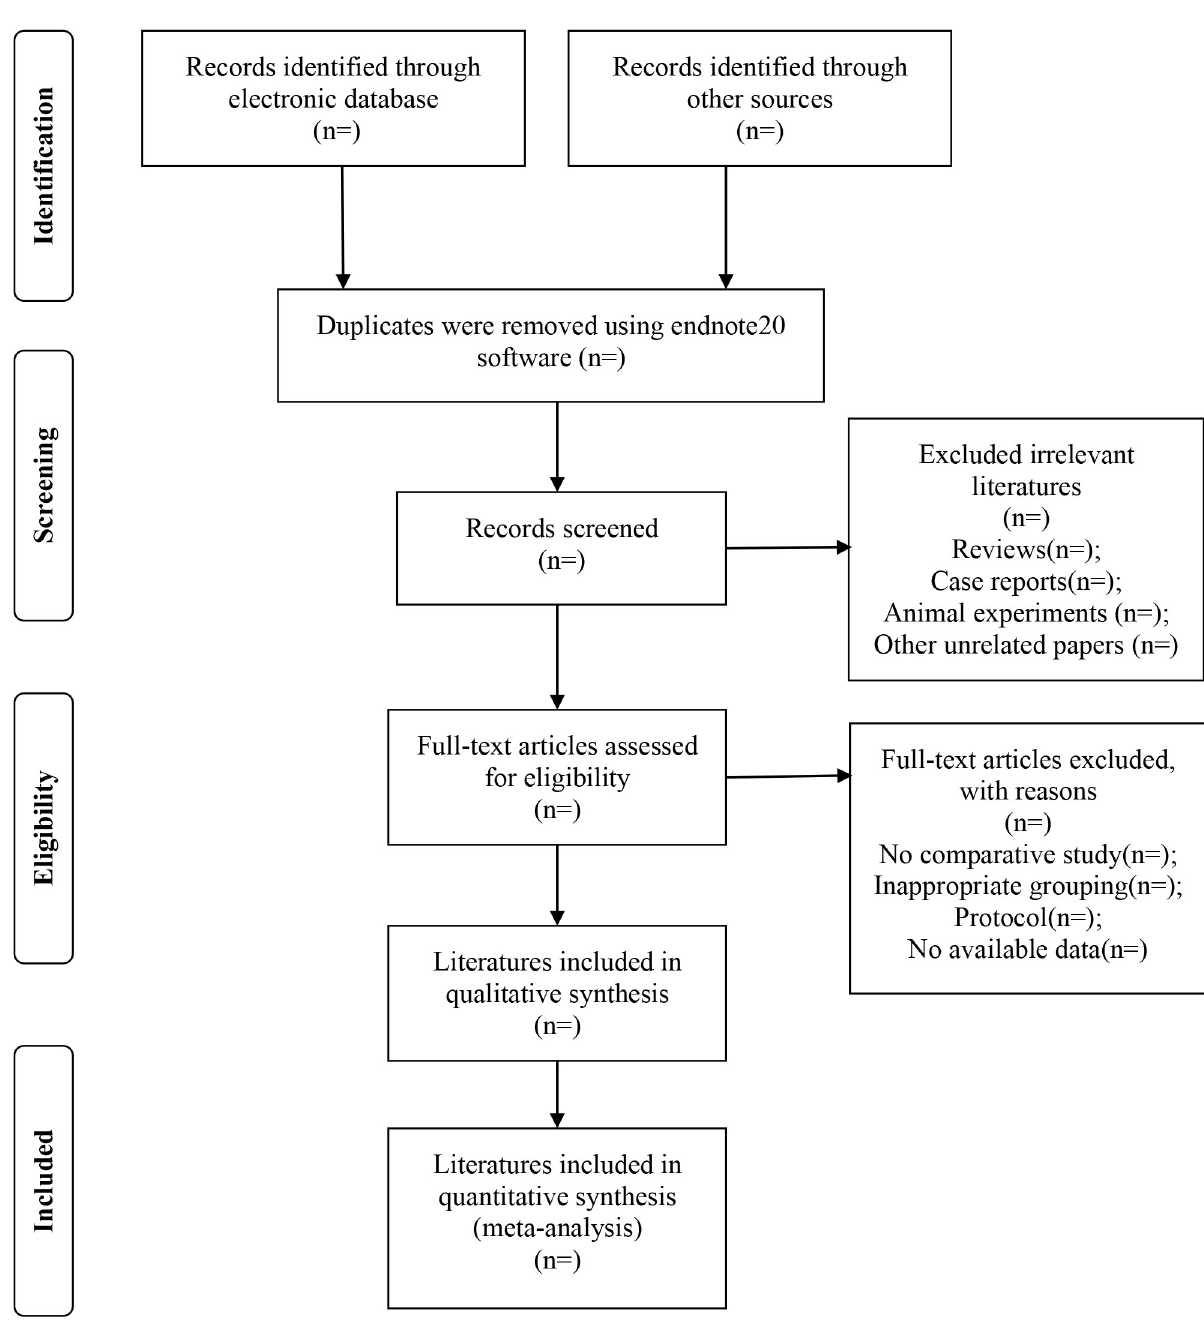
Fig 1. Flowchart of study